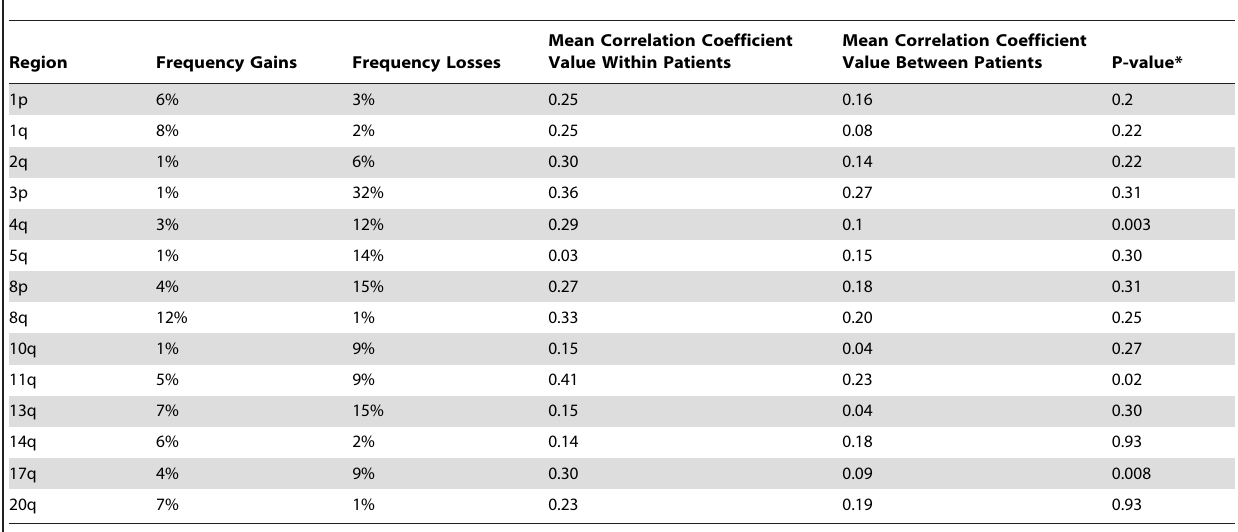
Table 1. Comparison of somatic changes within versus across individuals.